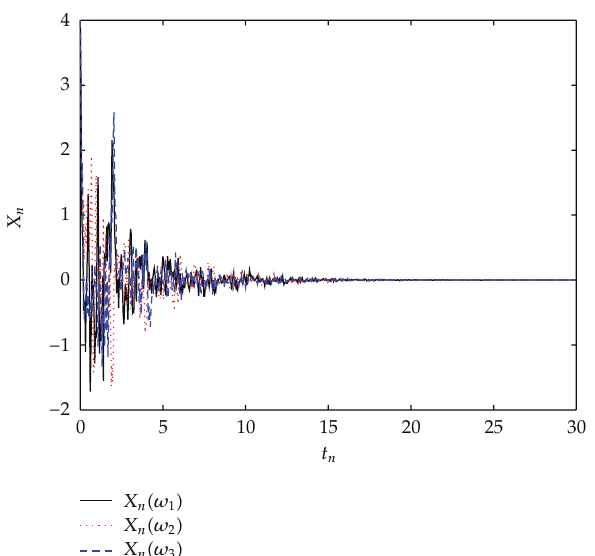
Figure 1: Almost surely asymptotic stability of the EM approximate solution X n with the stepsize h (cid:7) 1 / 25.